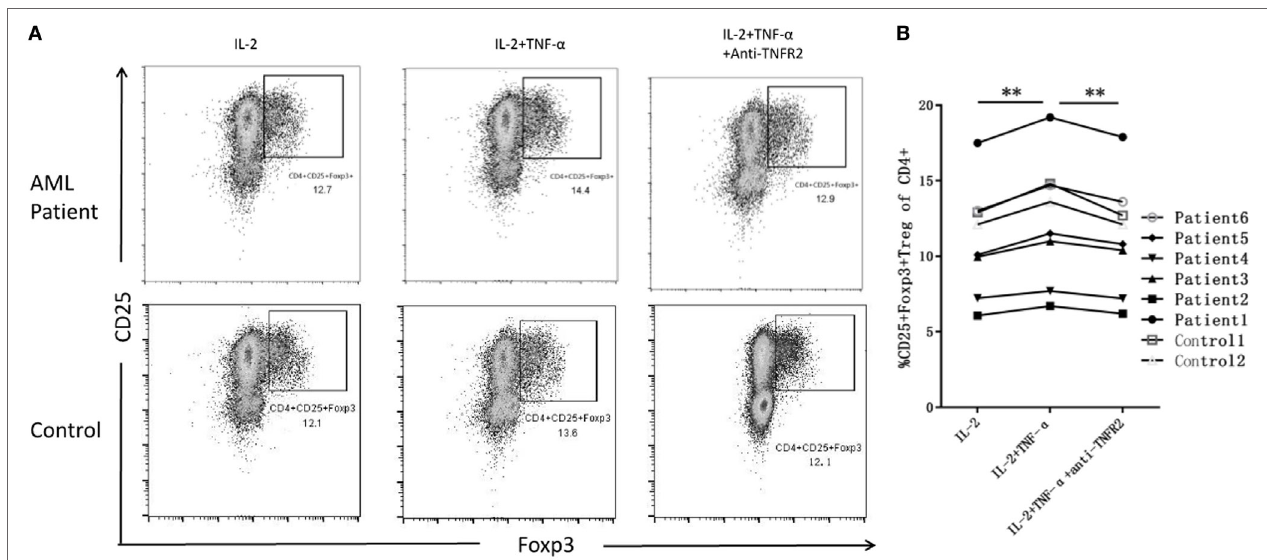
FigUre 6 | The expansion of regulatory T cells (Tregs) when treated with IL-2 alone, IL-2 plus tumor necrosis factor (TNF)- α , and IL-2 with TNF- α plus anti-TNF receptor-2 (TNFR2) antibody. (a) Representative flow plots of acute myeloid leukemia (AML) patients and controls confirm greater intracellular induction of CD4 + CD25 + Foxp3 + Tregs after added TNF- α , and the expansion of Tregs decreased when added anti-TIMFR2 antibody. (B) The expression of Tregs has been upregulated after added IL-2 plus TNF- α , and decreased when added anti-TNFR2 antibody in AML